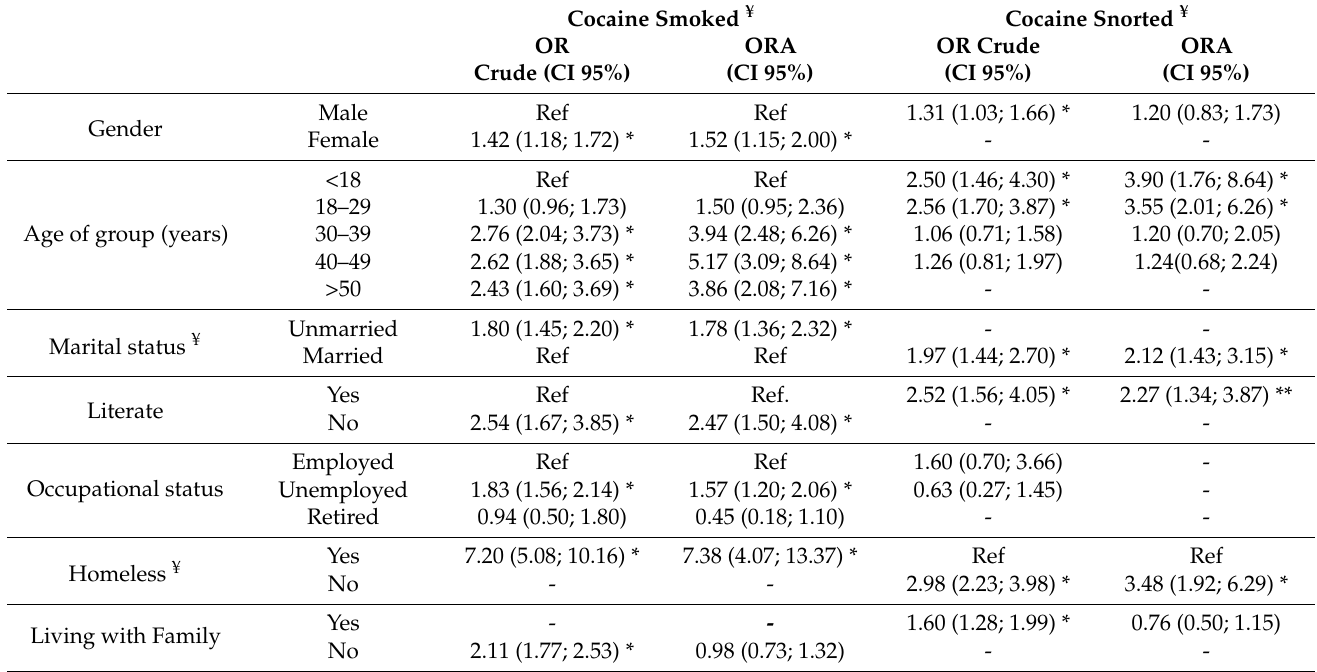
Table 2. Sociodemographic characteristics of cocaine (smoked and snorted) users reported by